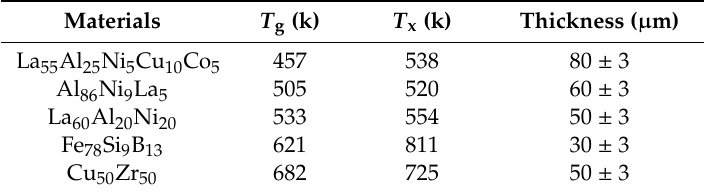
Table 1. The glass transition temperature ( T g ) and crystallization temperature ( T x ) of amorphous